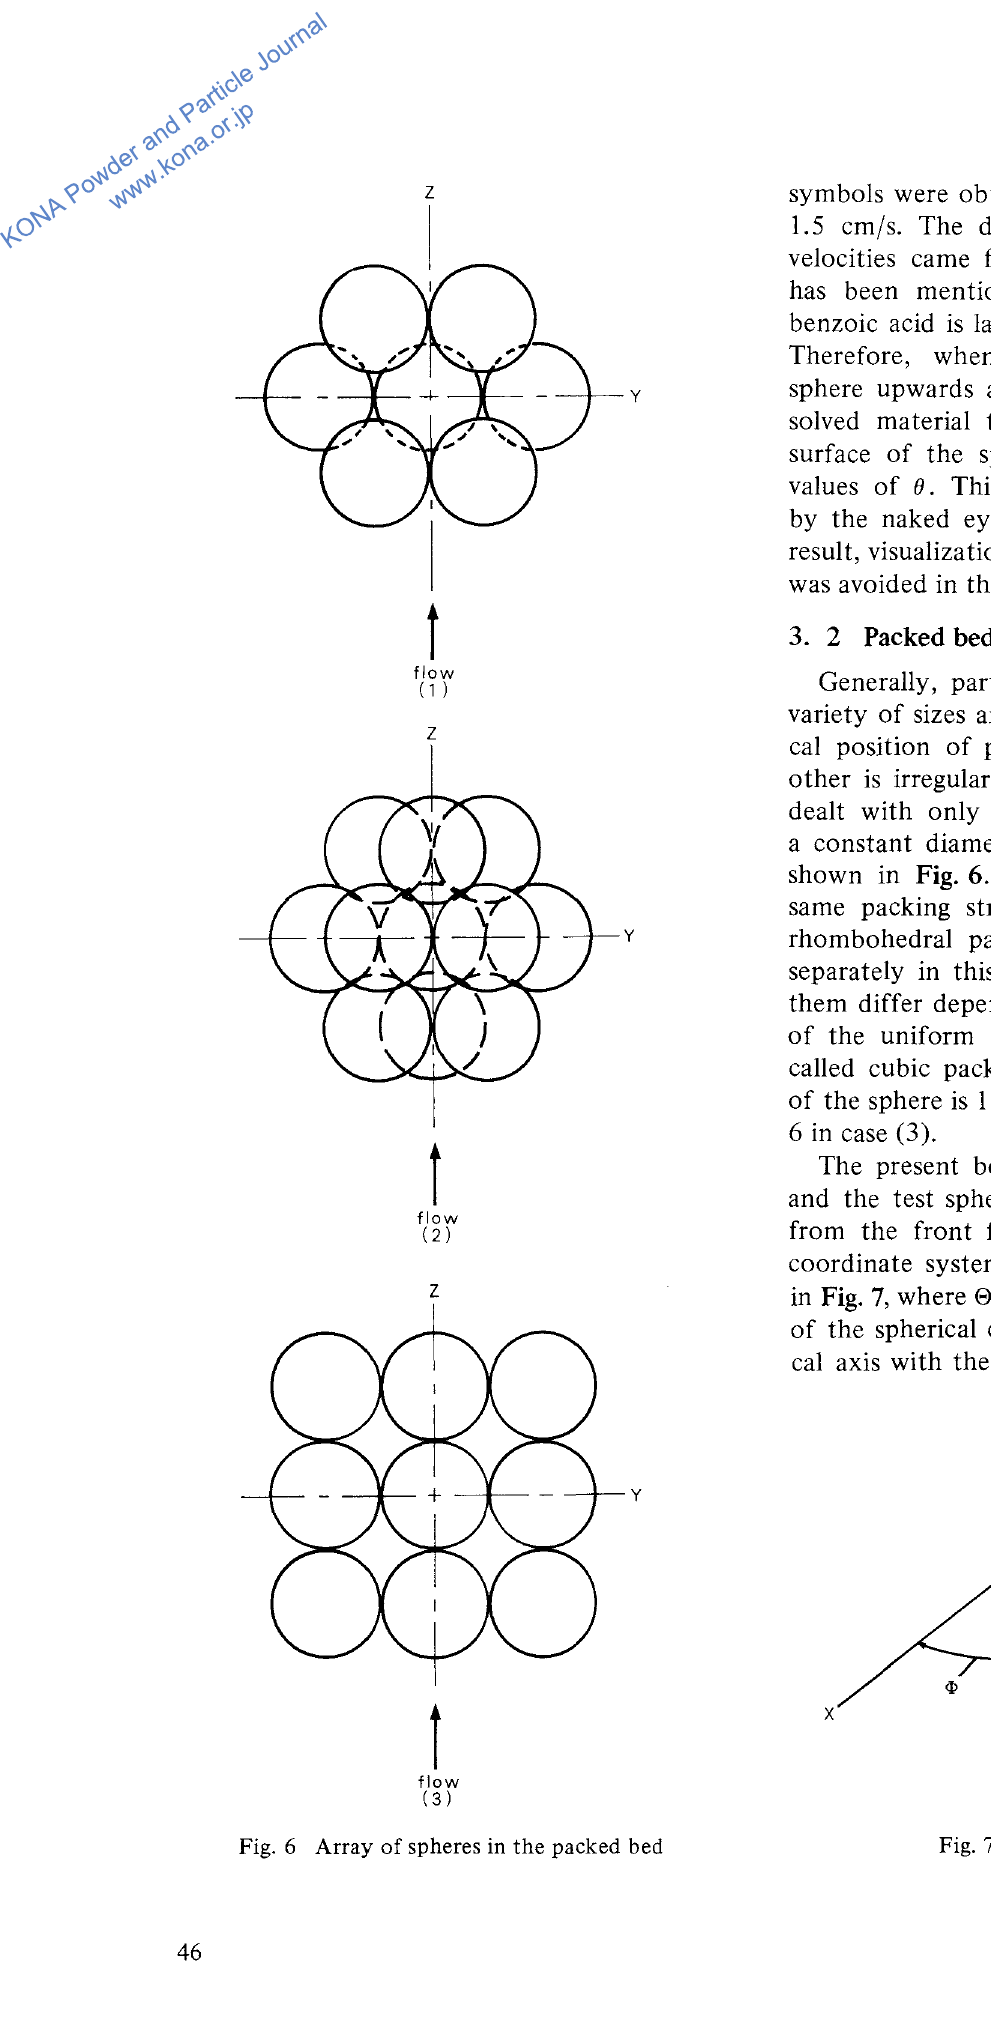
Fig. 6 Array of spheres in the packed